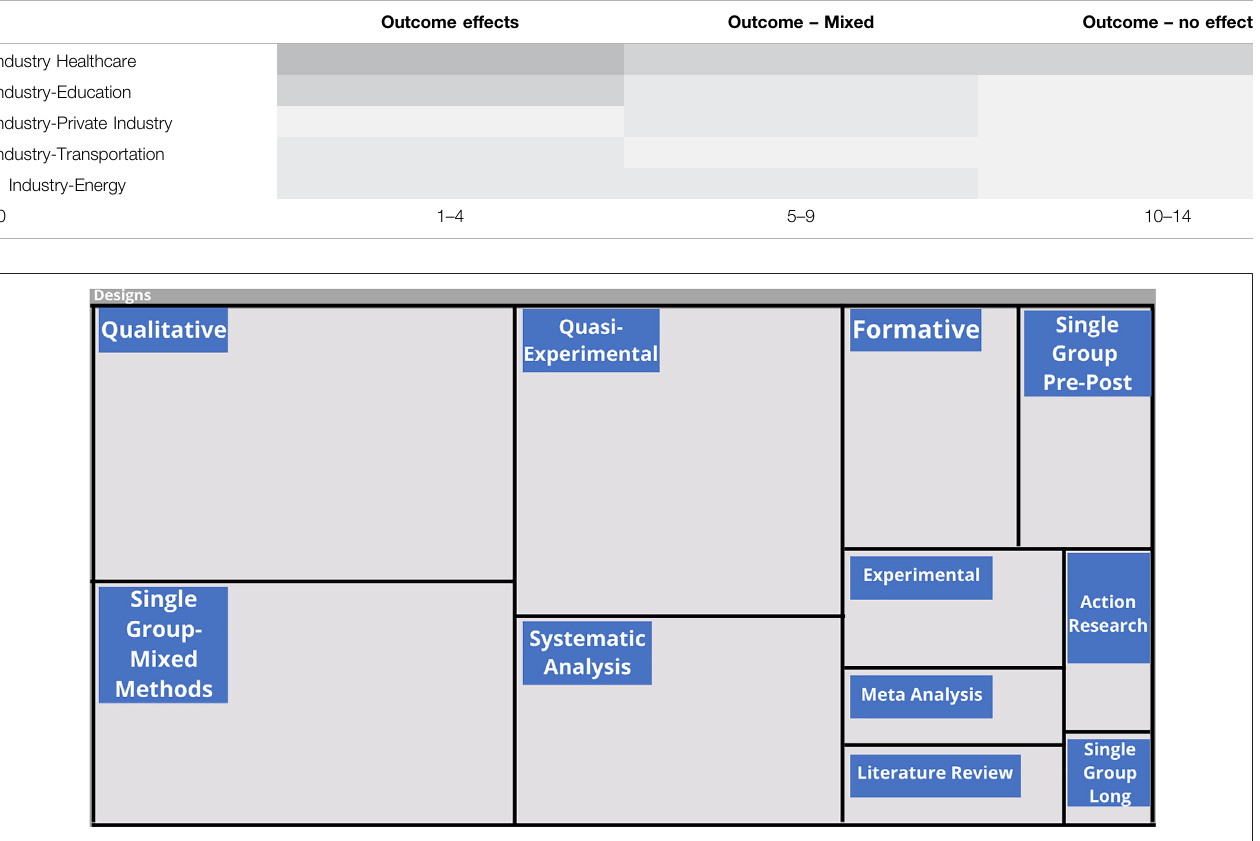
FIGURE 5 | Design node tree